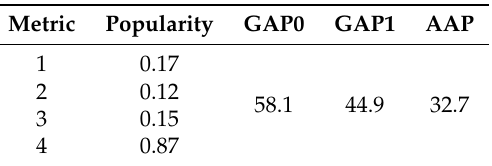
Table 6. Calculation of GAP0, GAP1, and AAP on a simulated entity with 4 monitored individual metrics, exhibiting high popularity in one metric and low in the others.